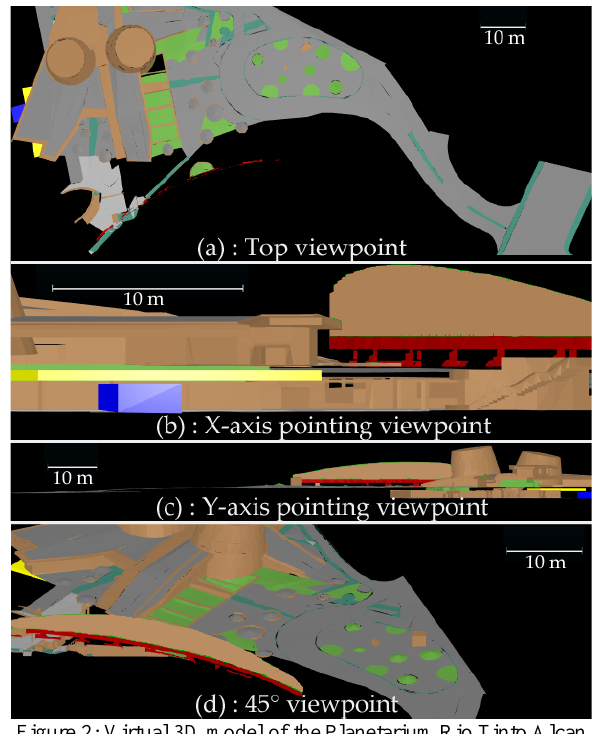
Figure 2: Virtual 3D model of the Planetarium Rio Tinto Alcan (Montreal city) visualized from the traditional combined points of view: top viewpoint (a), side viewpoints (b and c) and 45° viewpoint (d). Buildings and urban facilities are displayed in brown, ground in grey, green spaces in green and the easement in yellow. A 3D object (in blue) is added as an example of RRR conflict with the easement.